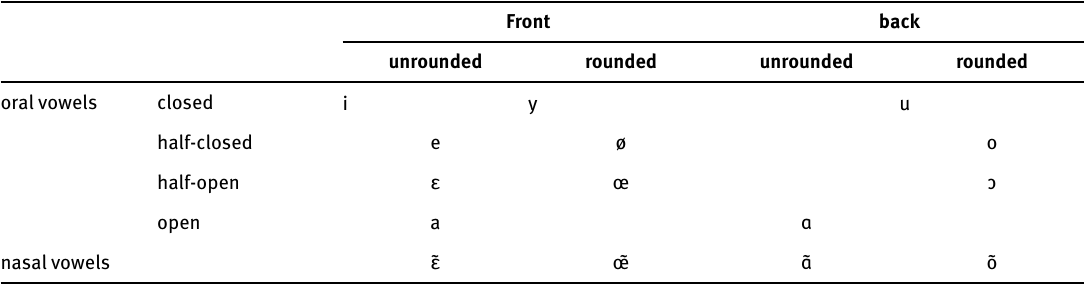
Table 2 . French vowel inventory (Bernard Tranel, 1987: 36) Front back unrounded rounded unrounded rounded